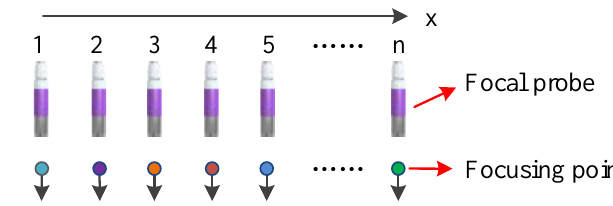
Figure 6. The imaging process of the sfMAET-CPS.